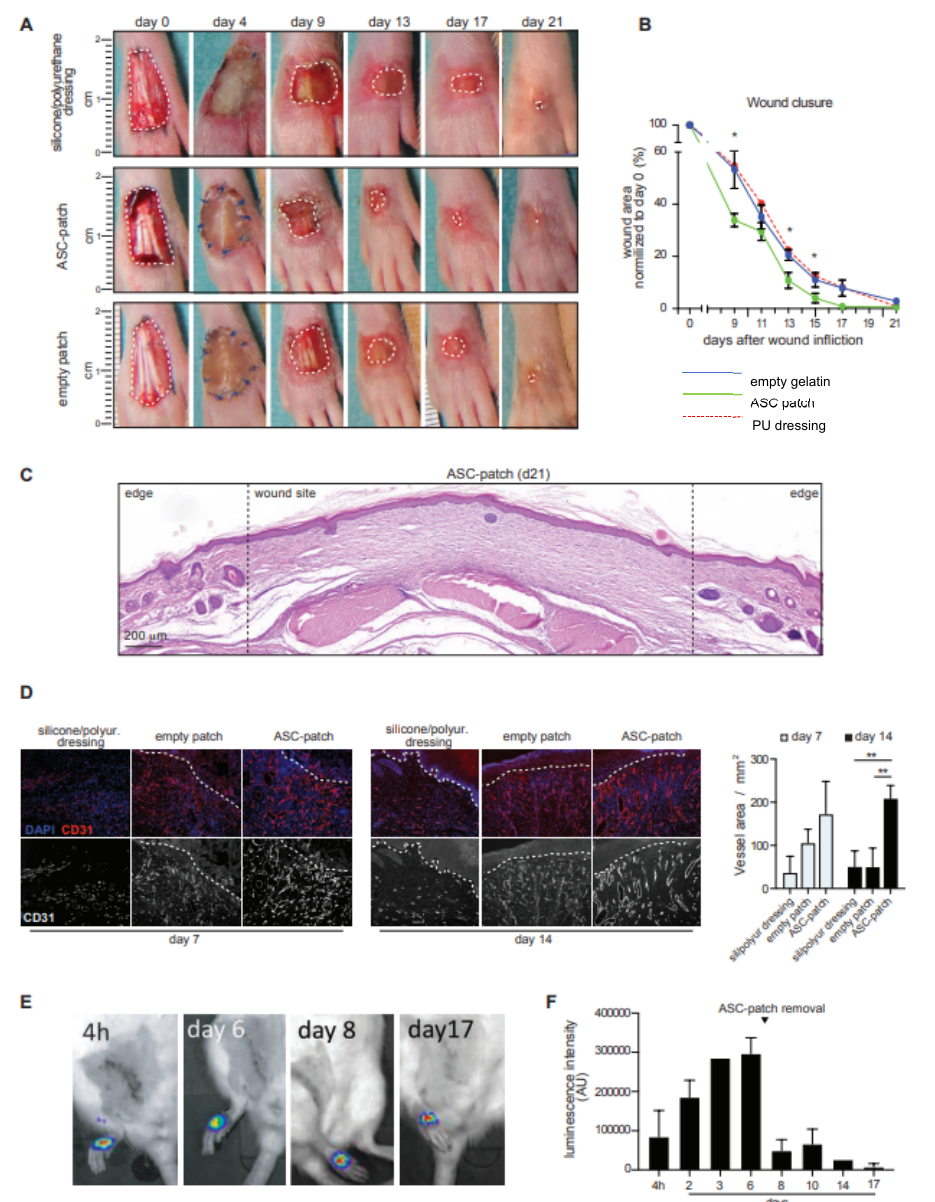
Figure 6. ASC-patches close ischemic wounds faster than acellular gelatin sponge and silicon/polyurethane dressings, with an increased vascularization of the granulation tissue. ASC- patches, empty gelatin sponge or a standard dressing of silicone/polyurethane were sutured on a full thickness wound on the ischemic foot of Wistar rats. Treatment was kept in place for the initial 7 days. ( A ) Representative macroscopic images are shown at different time points. ( B ) Quantification of the wound area, as normalized to day 0. Shown are cumulative data from 6 ASC-patches and 5 empty patches. A representative silicone/polyurethan dressing is shown as control. ( C ) Representative HE staining of a wound treated with the ASC-patch at day 21. ( D ) Endothelial cell marker CD31 (red—top panel; grey—bottom panel) and DAPI (blue, nuclei) immunofluorescent staining of the granulation tissue at day 7 and 14 (left). Quantification of the vessel area (defined by CD31 staining)/mm 2 (right). ( E ) Representative live imaging of rASC EFS FLuc after intraperitoneal injection of D-Luciferin. Images are taken one hour after the substrate injection. ( F ) Quantification of the luminescence emitted in the wound zone over 17 days post-treatment. Cumulative data from 3 rats is shown. Mean ± SD; non-parametric Mann–Whitney t test: ** = p < 0.01; * p < 0.05. AU: Arbitrary